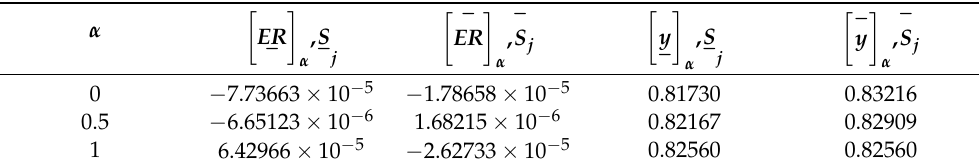
Table 5. The approximate solutions and errors for Equation (47) using the tenth-order FF-OHAM when ω = 1.9 at x = 0.1 for all α ∈ [ 0,1 ]